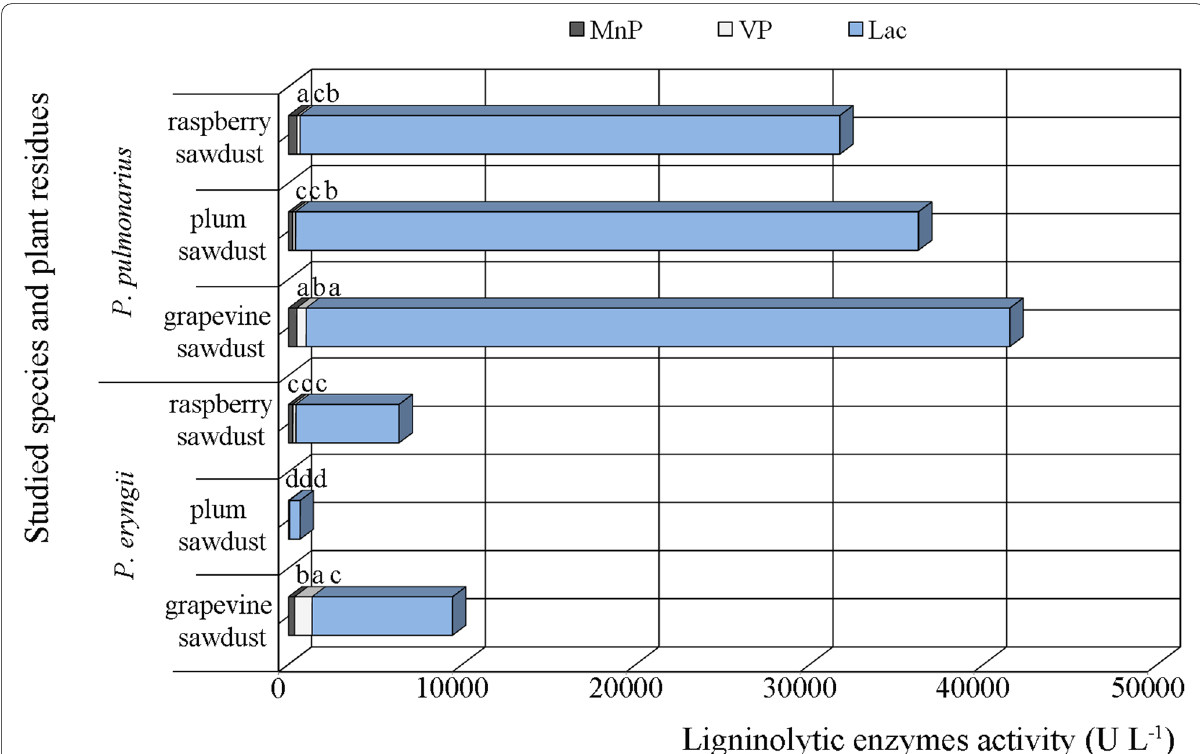
Fig. 1 Activity of Mn-dependent peroxidases, versatile peroxidases and laccases of Pleurotus spp. depending on the type of pomiculture residues. The values with the same superscript letter (for each enzyme) are not significantly different ( p <